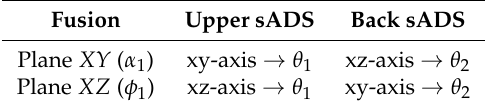
Table 2. Merged data is obtained in two different fusions using the shoulder ADS